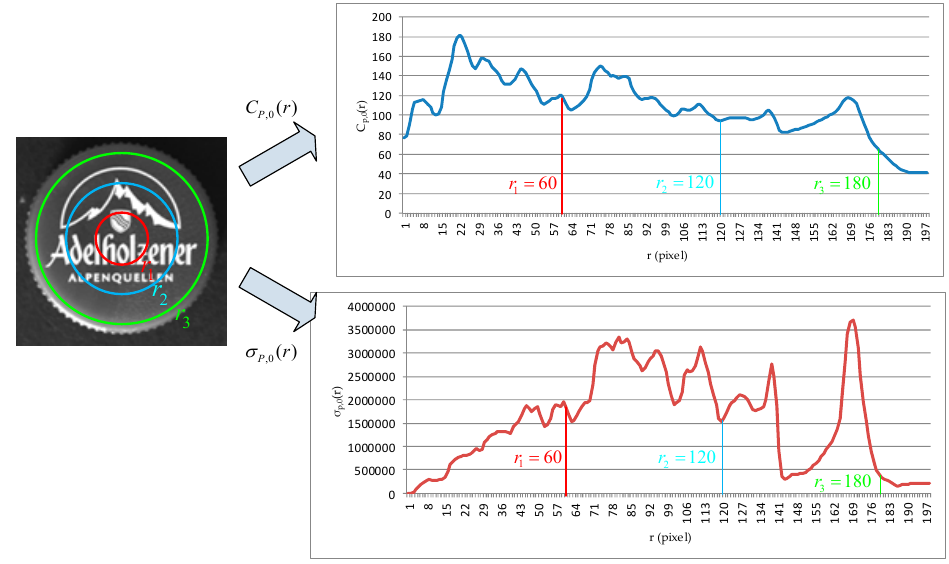
Figure 2. Main concepts of ring ‐ and variance ‐ projection.